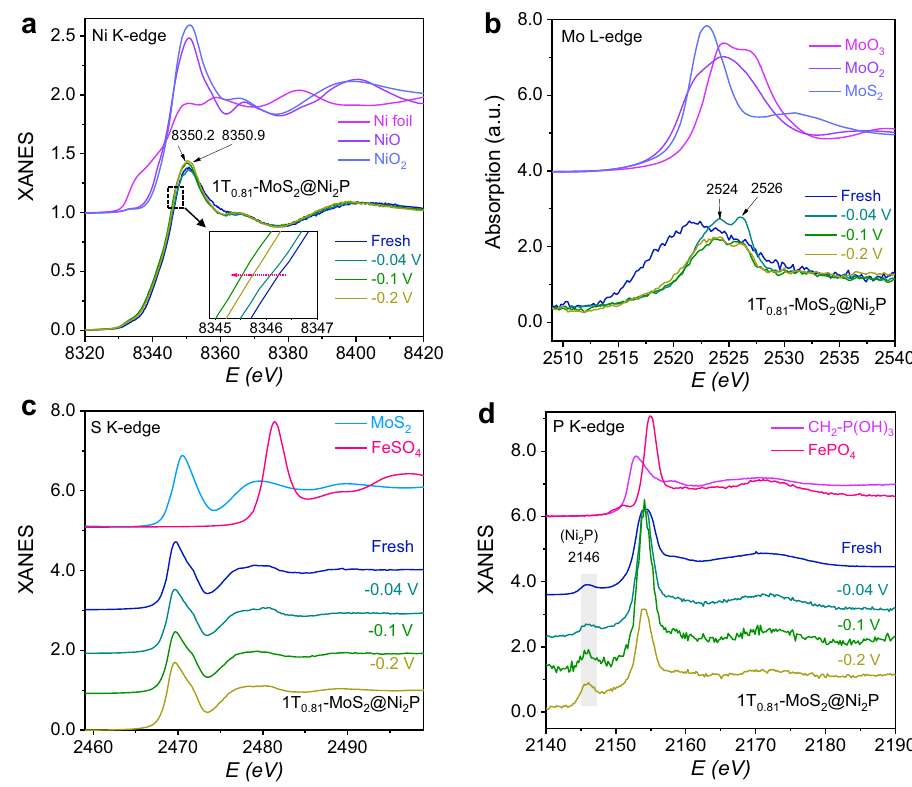
Fig. 5 XANES spectra measurements of fresh 1T 0.81 -MoS 2 @Ni 2 P catalyst and after being used in the HER process at − 0.04, − 0.1, and − 0.2 V vs RHE, respectively. a Ni K -edge XANES spectra of 1T 0.81 -MoS 2 @Ni 2 P catalyst and standards Ni foil, NiO, and NiO 2 . Inset, Magni fi ed pre-edge XANES region. b Mo L -edge XANES spectra of 1T 0.81 -MoS 2 @Ni 2 P catalyst and standards MoS 2 , MoO 2 , and MoO 3 . c S K -edge XANES spectra of 1T 0.81 -MoS 2 @Ni 2 P catalyst and standards MoS 2 , and FeSO 4 . d P K -edge XANES spectra of 1T 0.81 -MoS 2 @Ni 2 P catalyst and standards CH 2 -P(OH) 3 , and FeSO 4